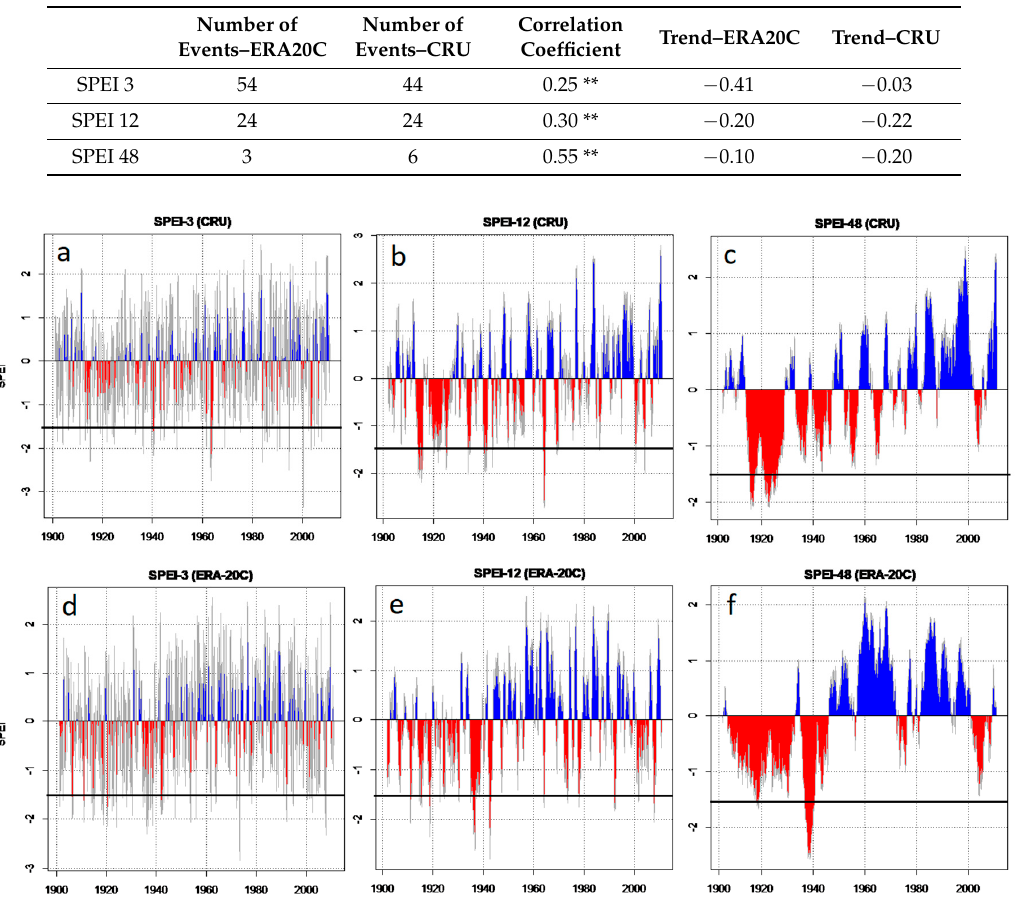
Table 2. Number of events, Spearman correlation coefficient and trend for observation (IAG) and reanalysis (ERA20C) data in the ESP region, from 1901 to 2010. The trend is represented by the slope of the regression line. * indicates the significant trend (according to MK test) or correlation coefficient (according to t-test) at α = 0.1 and ** indicates the significant trend/coefficient at α = 0.05.